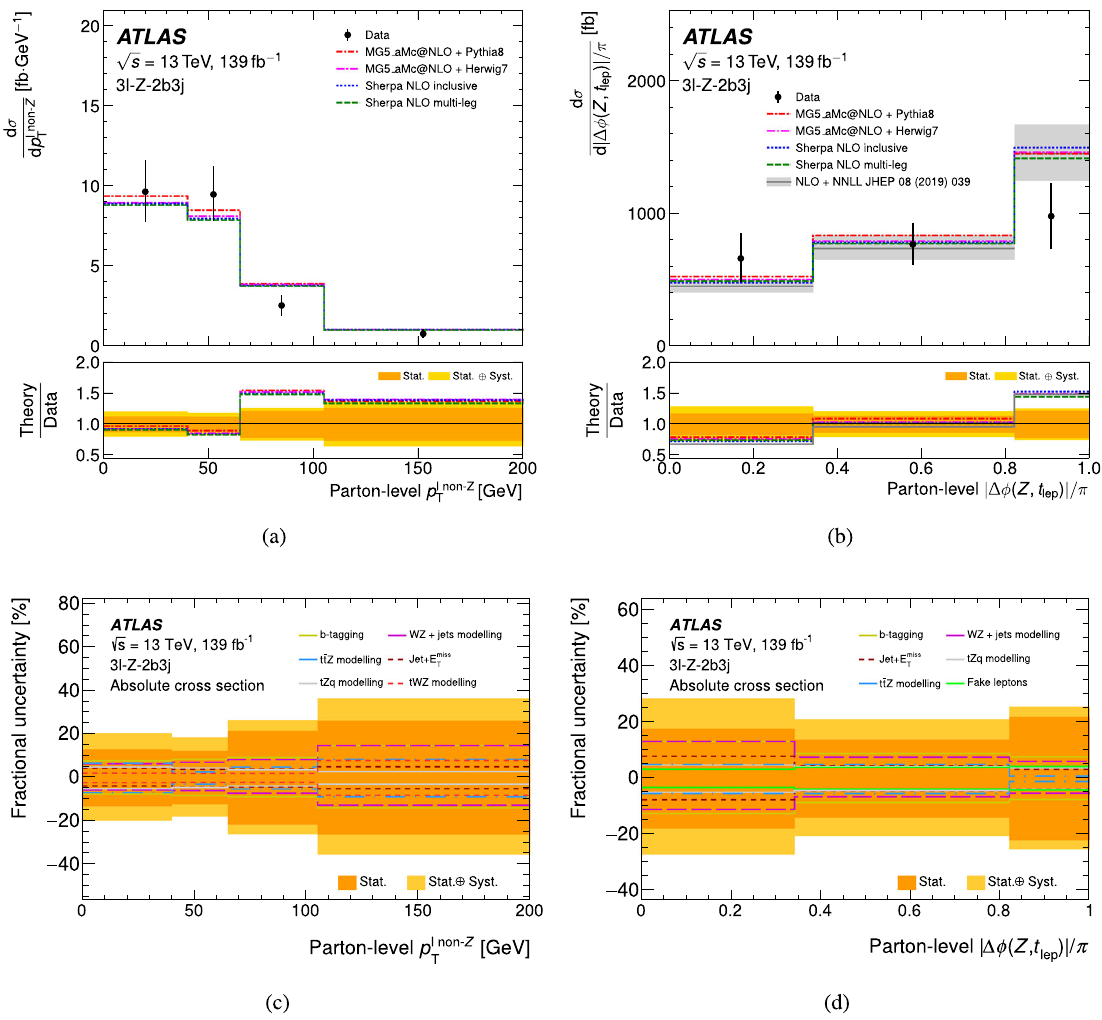
Fig. 13 Absolute differential t ¯ tZ cross sections measured at parton level as a function of a p (cid:11), non- Z the Z boson and the reconstructed top quark. c , d Show the relative contributions from different categories of systematic uncertainties per